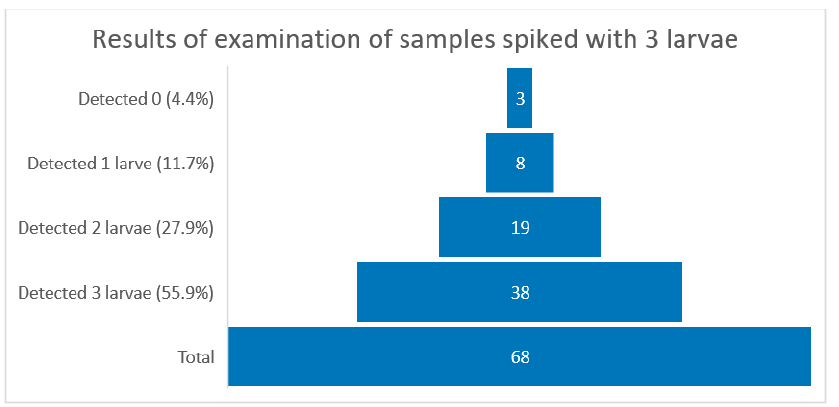
Figure 2. Graphical interpretation of the distribution of samples spiked with three larvae (number of laboratories in bricks).